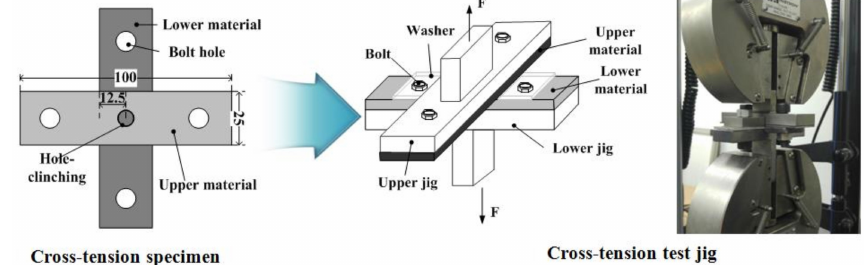
Figure 5. Cross-tension specimen and test jig.